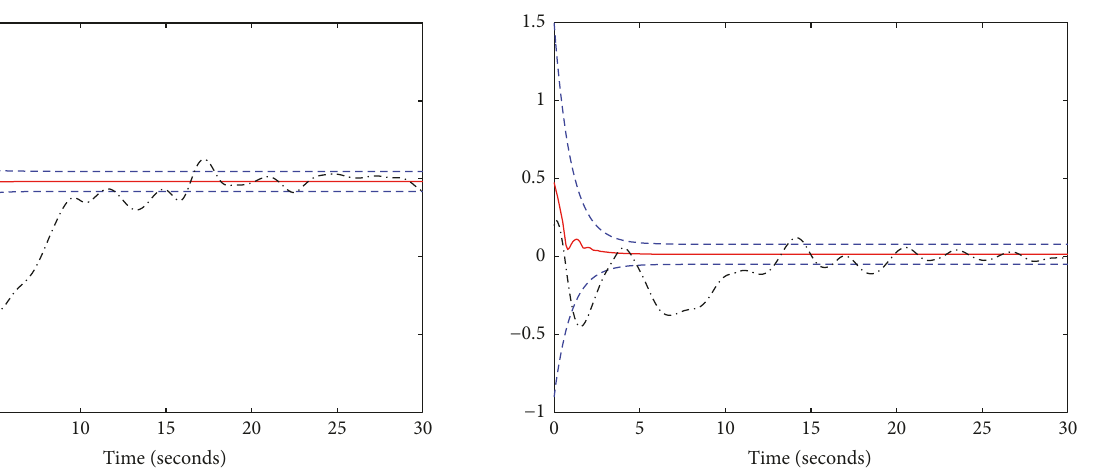
Figure 3: Angular position tracking error 𝑒 12 : ANC with error transformation method (—), ANC method in [30] (- ⋅ - ⋅ ), and the error bounds (- - -).